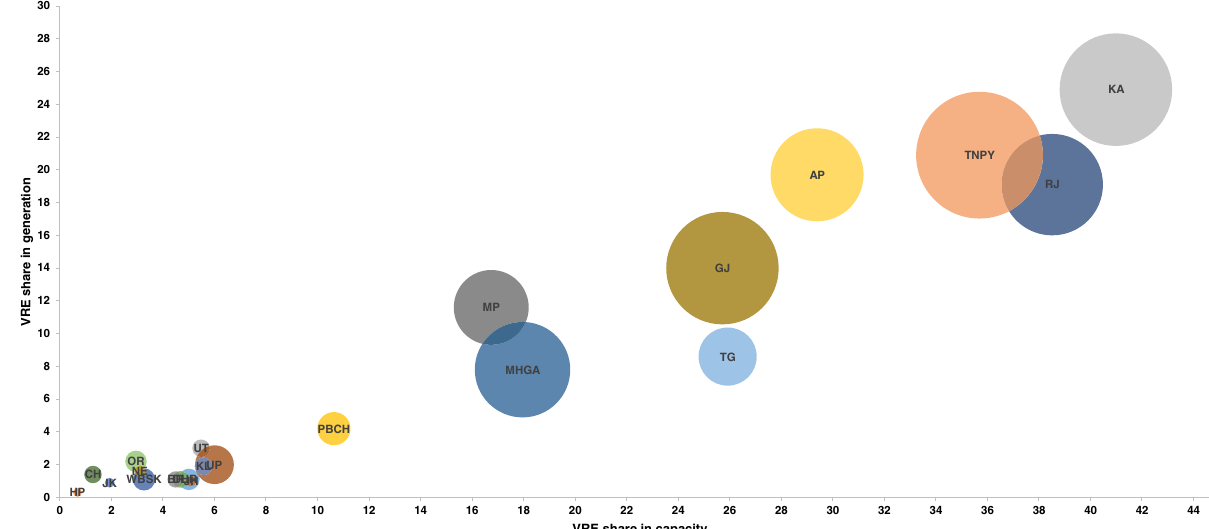
Fig. 1 | Variable Renewable Energy (VRE) share by state in capacity and gen- eration,2019 97 . ThexandyaxisrepresentVREshareofcapacityandgenerationin each state ’ s total capacity and generation respectively. The bubble size represents the share of electricity generation by VRE in each state with respect to the total electricitygenerationinIndia.TamilNaduhasthehighestshareofVREintotalIndia generation. Karnataka has the highest share of capacity and generation among